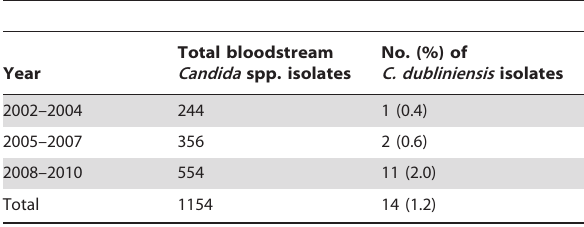
Table 1. Occurrence of C. dubliniensis among bloodstream isolates of Candida